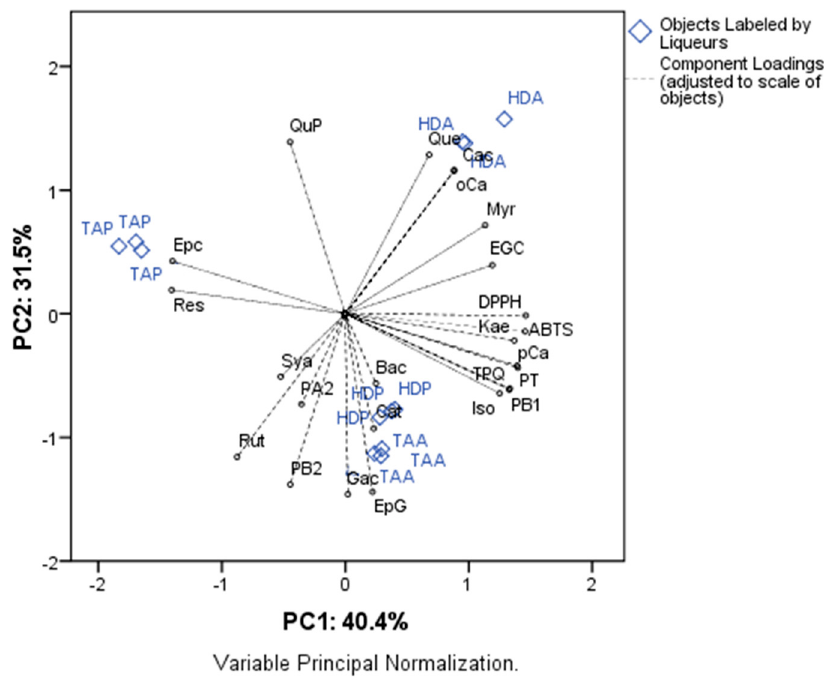
Figure 2. Principal component analysis between the phytochemical profile and antioxidant activity of mango liqueurs obtained by different methods. Legend: had = Haden mango peel liqueur by alcoholic maceration, HDP = Haden mango peel liqueur by maceration with pectinase, TAA = Tommy Atkins mango peel liqueur by alcoholic maceration, TAP = Tommy Atkins mango peel liqueur by maceration with pectinase.